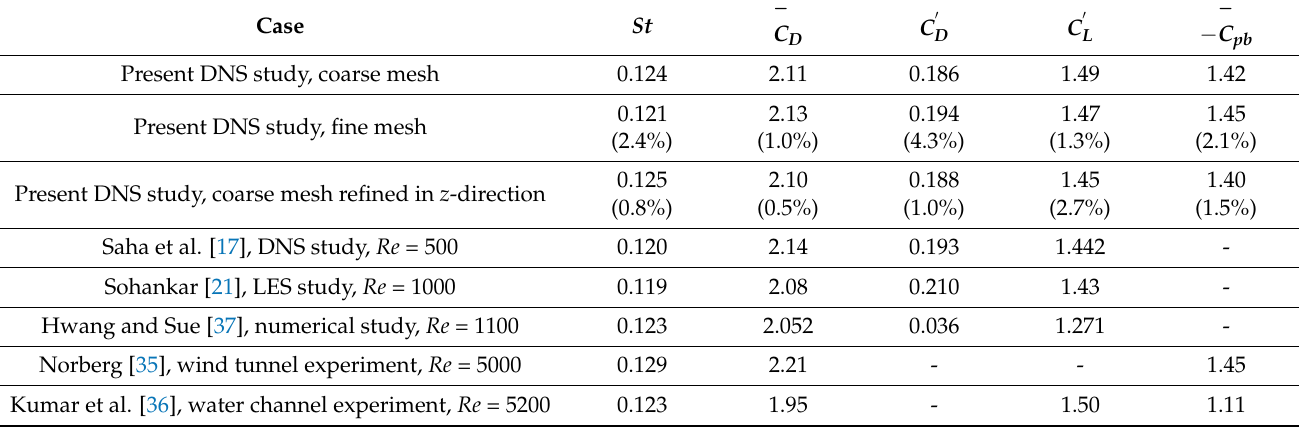
Table 2. Mesh dependence check for a square cylinder in crossflow ( α = 0 ◦ ). The relative errors in the brackets are calculated by using the results obtained from the coarse mesh as reference